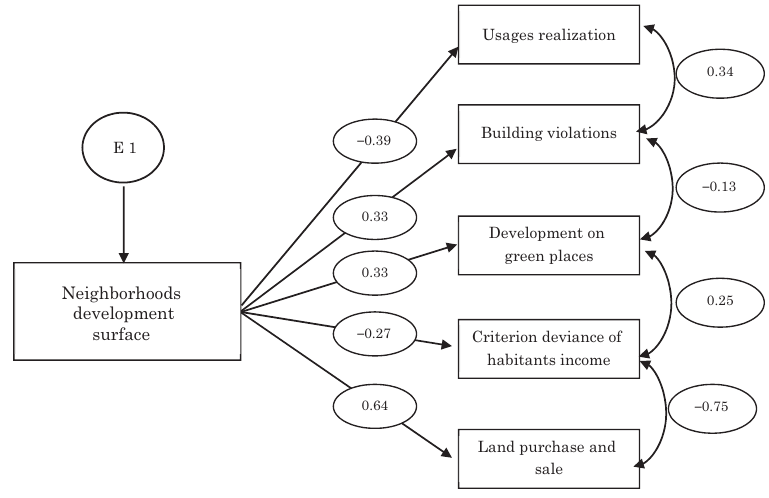
Fig. 5. Structural equations graphical analysis of urban land performance on neighborhoods development level with the AMOS model